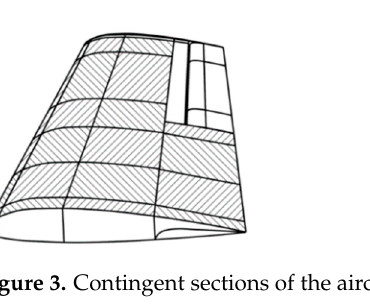
Figure 2. Aerodynamic forces represented in the form of loads that are applied to the conditional section of the aircraft wing skin. N x —longitudinal force in the plane, N y —transverse force, q xy — tangential force flow, and p—pressure, perpendicular to the plane.